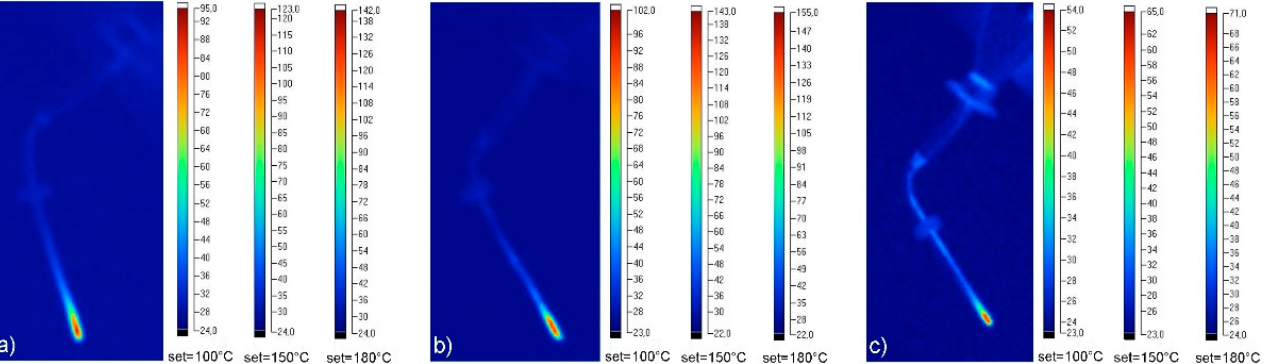
Figure 3. Temperature profiles along the pluggers at temperature settings of 100 ◦ C, 150 ◦ C, and 180 ◦ C. F-06 plugger ( a ); XF-30/04 plugger ( b ); and ML-12 plugger ( c ). Along the scale bar, it is possible